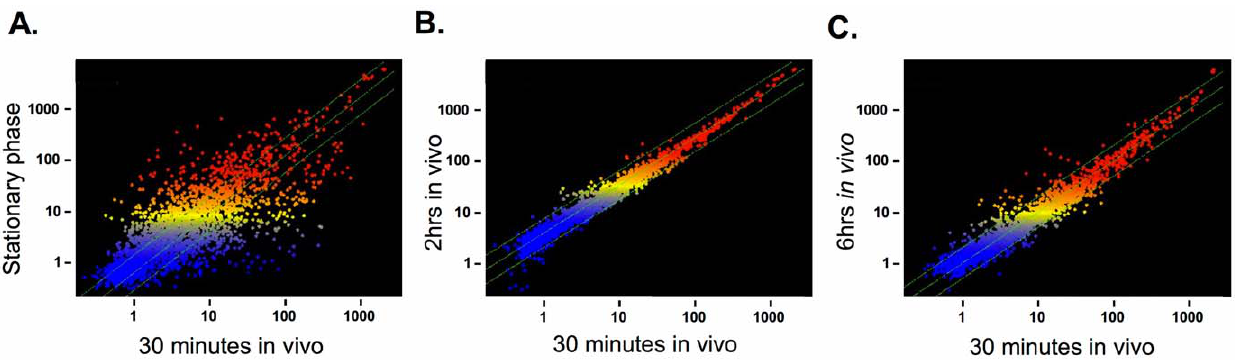
Figure 2. Changes in gene expression between experimental conditions. The scatter plots shown compare gene expression between cells isolated from stationary phase growth and those recovered after 30 9 residence in the mouse lung (panel A), after 30 9 vs. 120 9 in the lung (panel B) in the lung and after 30 9 vs. 6 hours in the lung (panel C). Each point represents the expression of a single transcript. The axis denominated by the relative probe intensity values. Probes with the same intensities for each condition compared fall on the diagonal line. Two fold change lines are on either side of the diagonal.